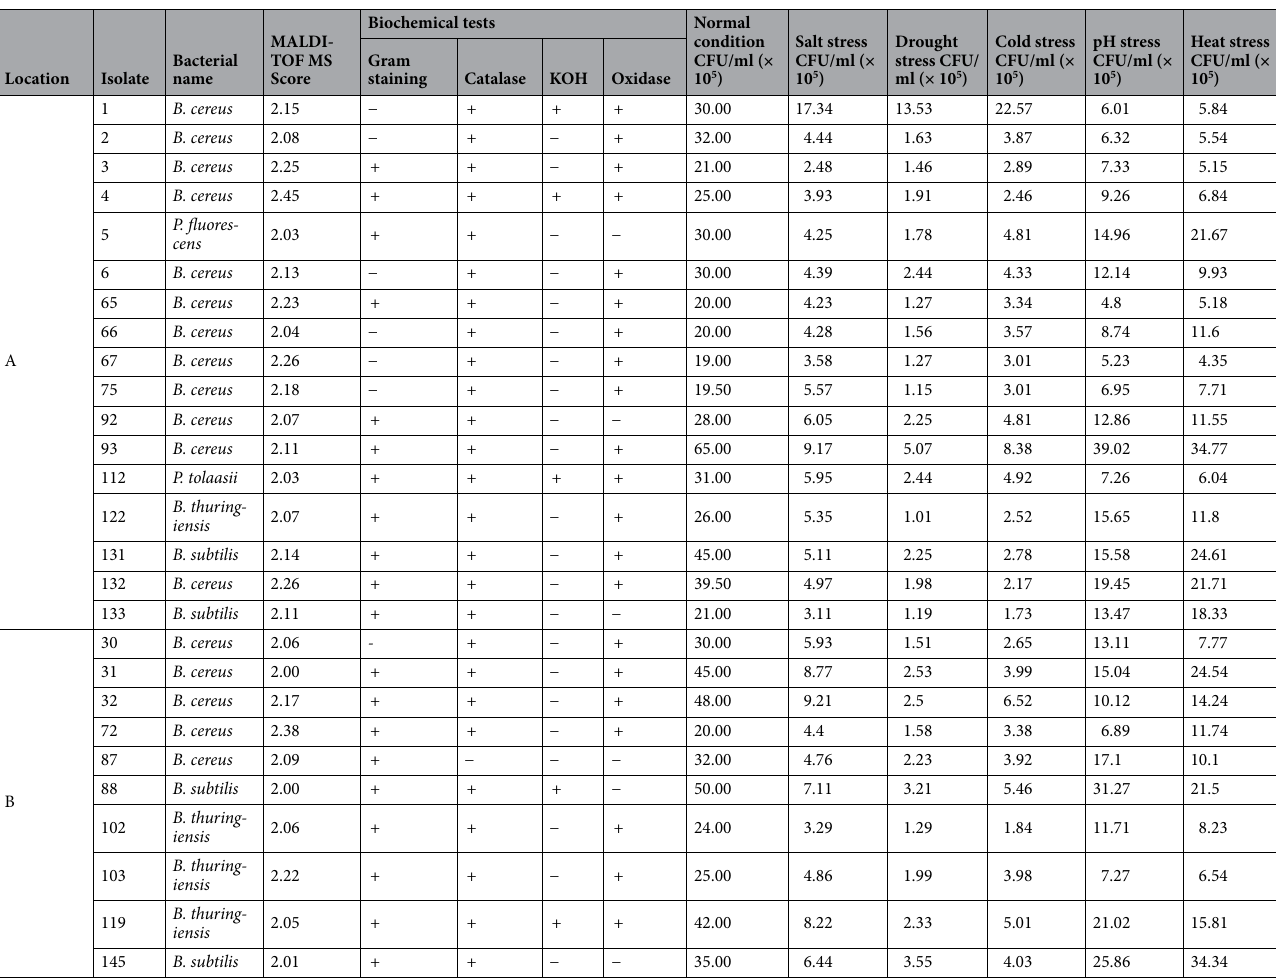
Table 3. Investigation of bacterial diversity along with two coastal deserts by MALDI TOF and biochemical complementary tests and impacts of cold, dryness, and salinity stresses on soil bacteria isolated from locations A and B, 15 h after inoculation. Isolates that were undoubtedly identified to genus or species level by a valid MALDI-TOF MS score of ≥ 2.0 are shown. a and b were indicated sampling sites where the bacteria were isolated. Basal media was Muller Hinton for normal and stress conditions.